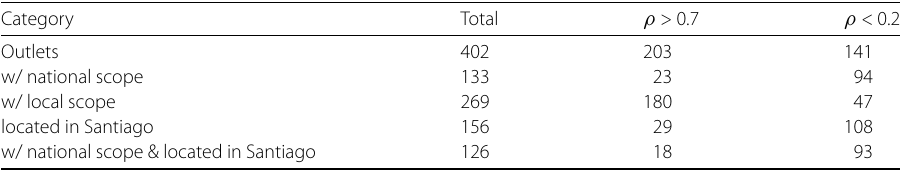
Table 2 Stats about the news outlets’ correlation